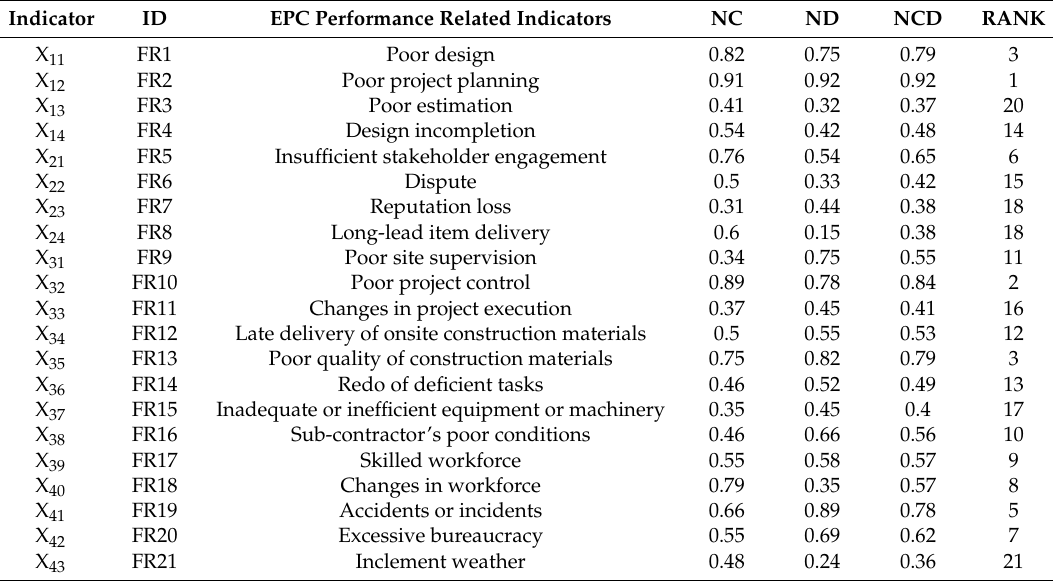
Table 3. Ranking EPC critical factors on project performance in large-scale residential construction projects by head contractors.